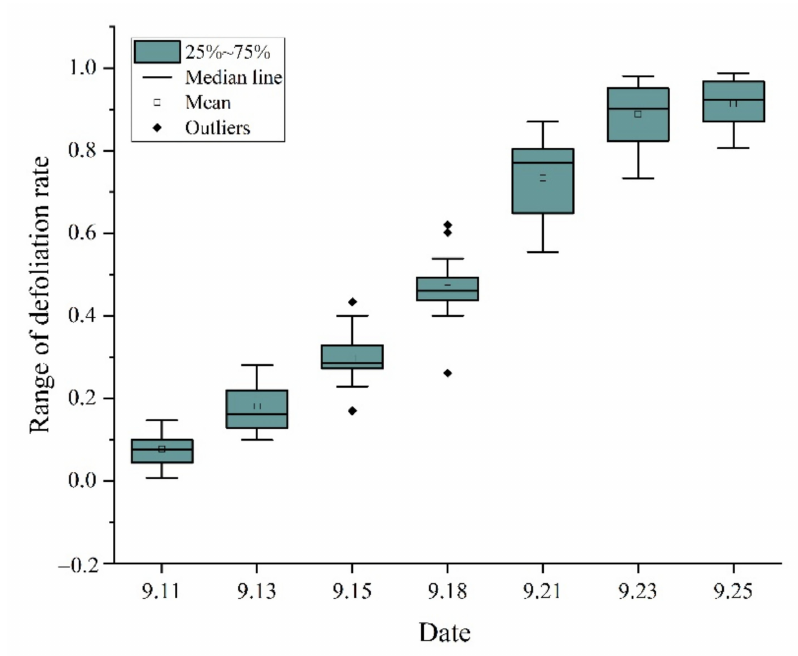
Figure 4. The distribution results of the defoliation rate from the ground survey.